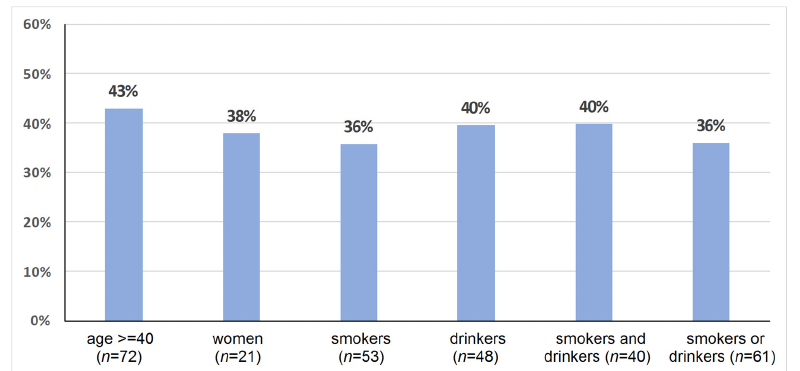
Figure 2. Percentage of HPV-positive results depending on qualitative variables (age, sex, addic- tions) in the HNSCC group (N = 76). The total number of study cases is given in parentheses next to the variable.